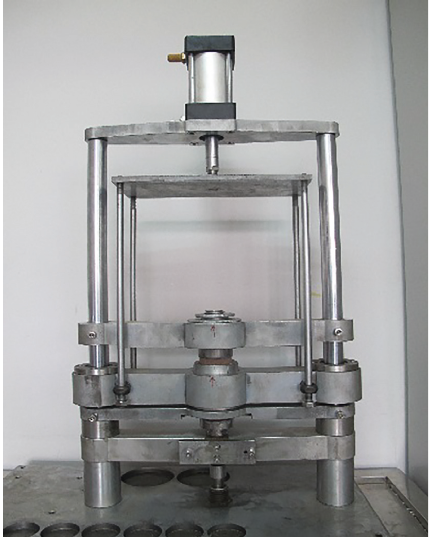
Figure 1: Bond centring device.